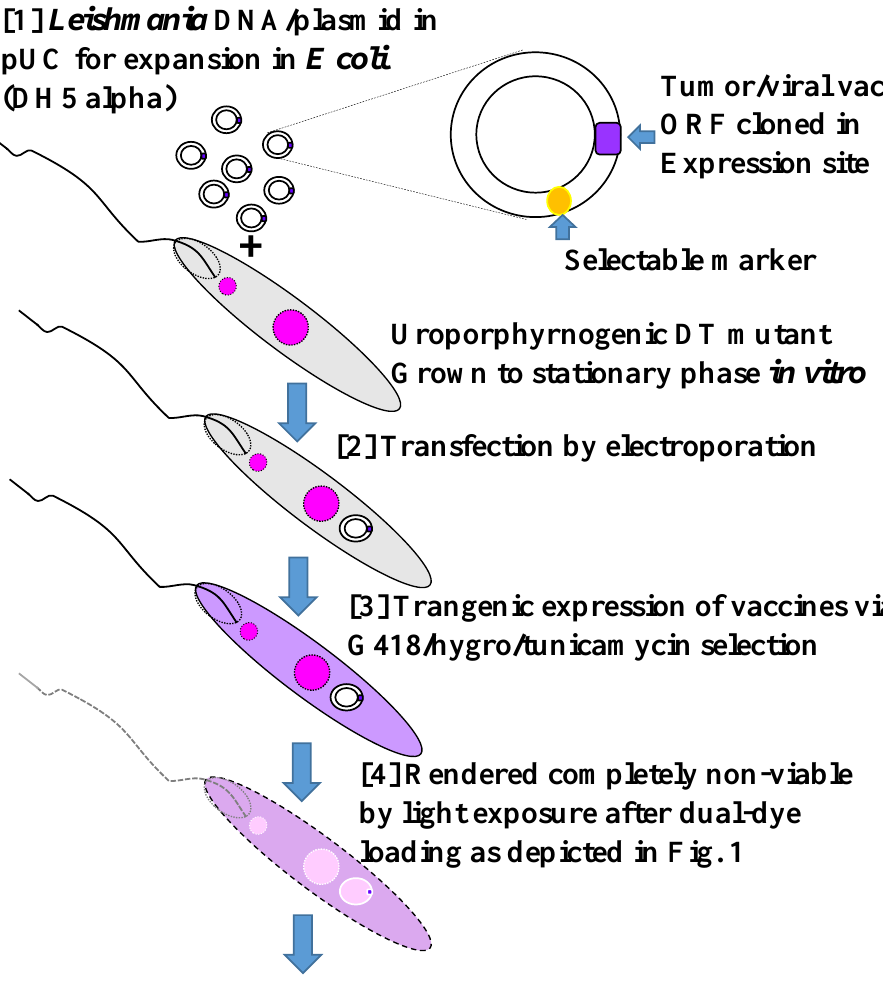
Figure 2. Schematic depiction of transgenic production of vaccines in DT uroporphrinogenic Leish- mania and their complete inactivation by dual dye-loading followed by light exposure. See Figure 1 for ALA-induced cytosolic accumulation of uroporphyrin 1 in DT Leishmania and loading of their endosomes with cationic phthalocyanine. Workflow: [ 1 ] Clone cDNAs of tumor/viral vaccines into the expression site of a Leishmania/E. coli shuttle vector for expansion in DH5-alpha and grow uropor- phyrinogenic DT mutants of Leishmania under tunicamycin (TUN) and G418 selection; [ 2 ] Transfect the DT mutants with the plasmids isolated by electroporation; [ 3 ] Select transfectants with hygromycin (HYG) for vaccine expression; [ 4 ] Place the transfectants under selection with HYG+TUN+G418; [ 5 ] Expose the transfectants to amino-phthalocyanine (PC) for endosomal uptake and to ALA for cytosolic accumulation of uroporphyrin I followed by longwave UV + Red light exposure for 1 O 2 - initiated inactivation (see Figure 1); [ 5 , 6 ] Verify complete loss of viability of the inactivated cells and their storage by means, as stated.